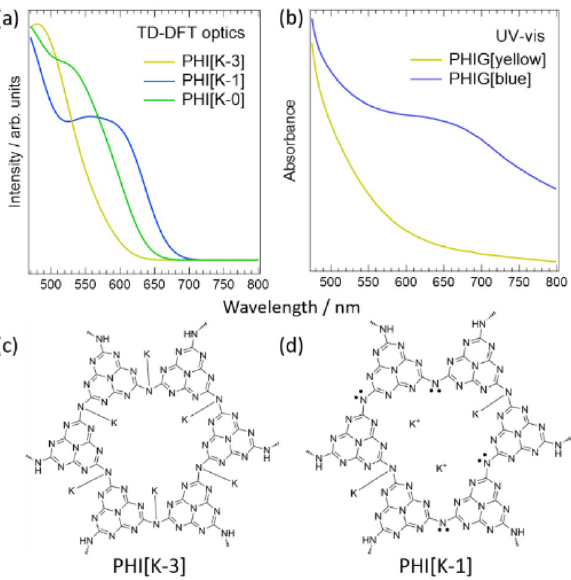
Figure 7. ( a ) Optical absorption spectra simulated by TD-DFT for the two PHI structures shown in ( c ) and ( d ). PHI[K- n ] represents the structure of PHI in which n Ks are bound to the nitrogens in PHI. ( b ) Experimental UV–Vis spectra of PHIG[yellow] and PHIG[blue], previously shown in Fig.